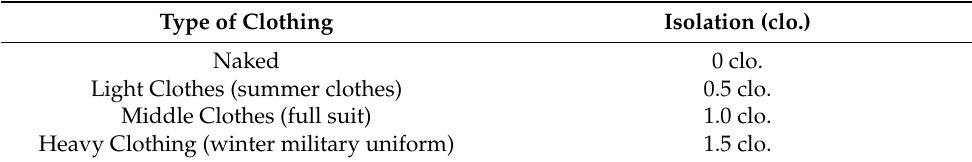
Table 2. Clothing insulation values.